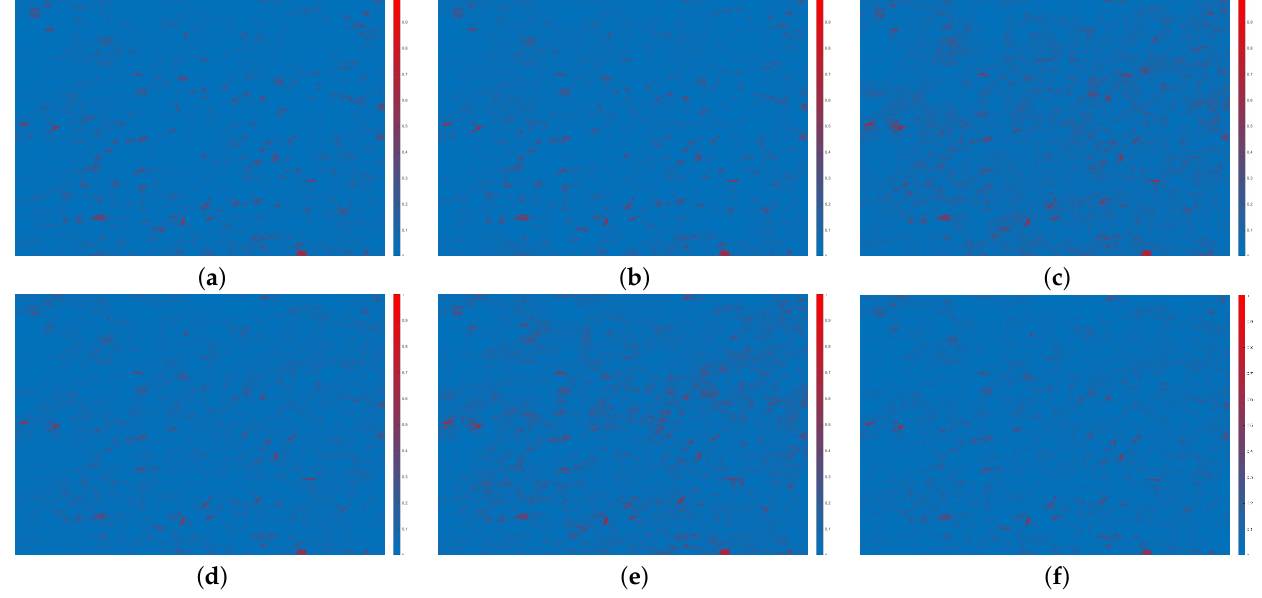
Figure 10. Comparison of the residual diagrams produced by various methods for the CIA dataset on 4 May 2002. ( a ) STARFM. ( b ) FSDAF. ( c ) DCSTFN. ( d ) EDCSTFN. ( e ) AMNet. ( f ) The proposed